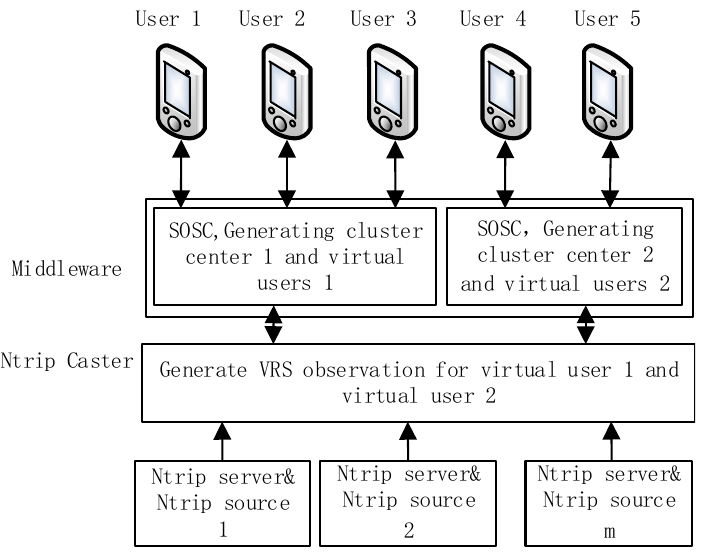
Figure 6. Integration of spatial clustering algorithm into the existing network RTK platform.